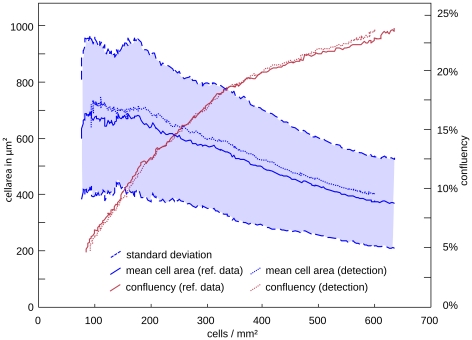
Cell density dependent cell area. The solid line shows the decrease of cell area with increasing cell density; the stained area depicts the distribution (standard deviation) of cell area. The solid line is calculated using the reference data, the dotted line using the threshold based cell detection algorithm described in this work. The confluency (red) is calculated in percent, i.e. the sum of all cell-pixels divided by the pixelsize of the overall observed area.